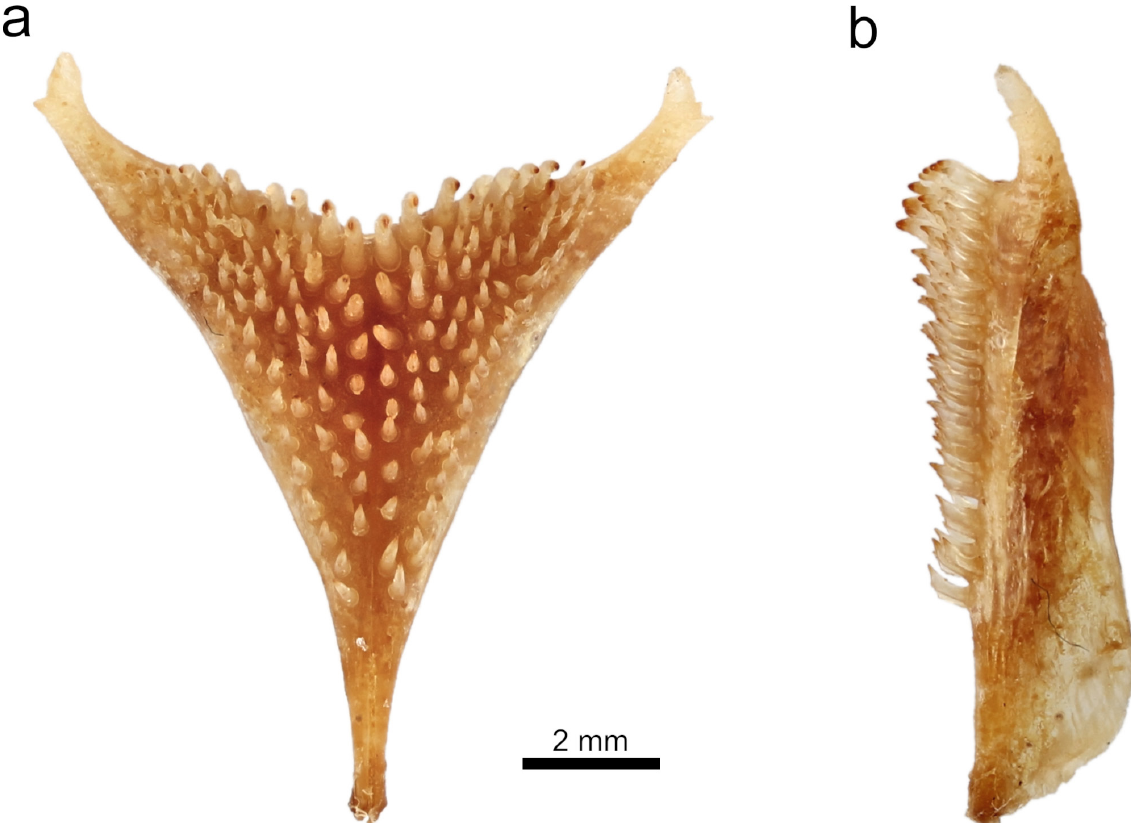
Fig. 31. Haplochromis curvidens sp. nov. (RMCA 2016.035.P.0217; 102.5 mm SL). a . Dorsal view of the lower pharyngeal jaw. b . Lateral view of the lower pharyngeal